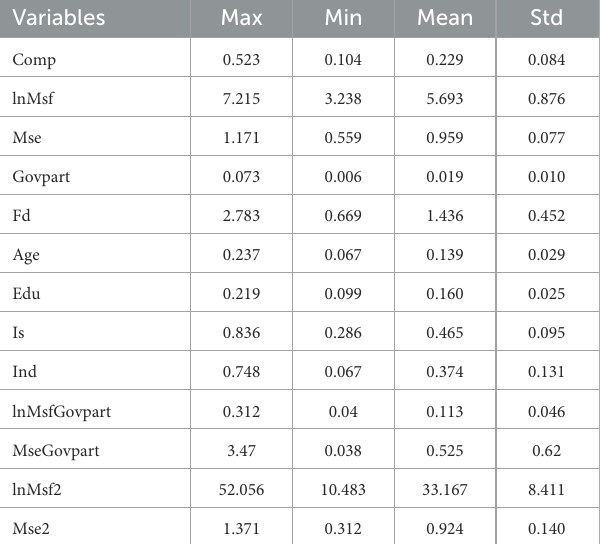
TABLE 2 Statistical description of data for each